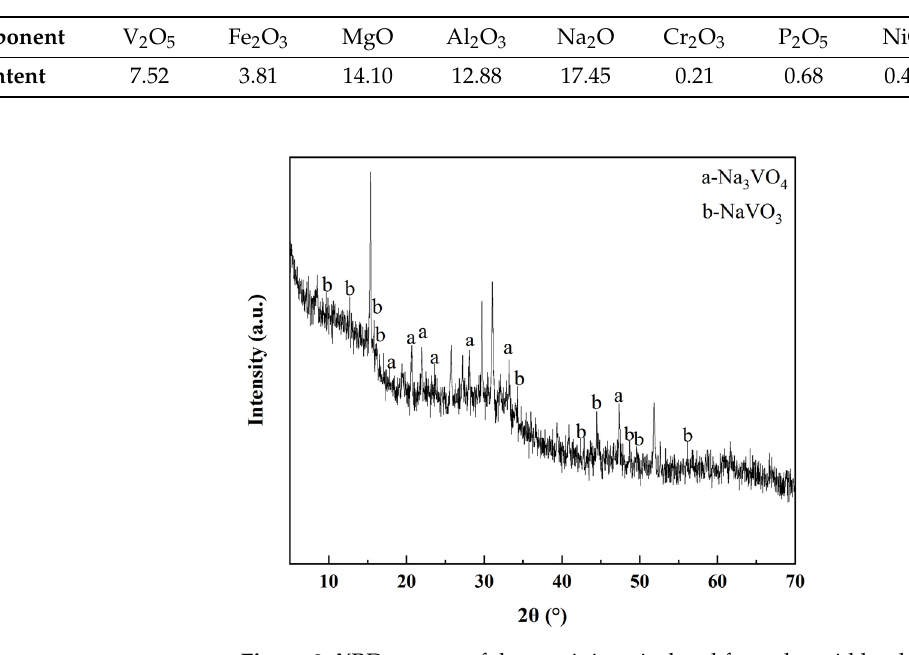
Table 2. Composition (wt%) of the precipitate isolated from the acid leaching solution.